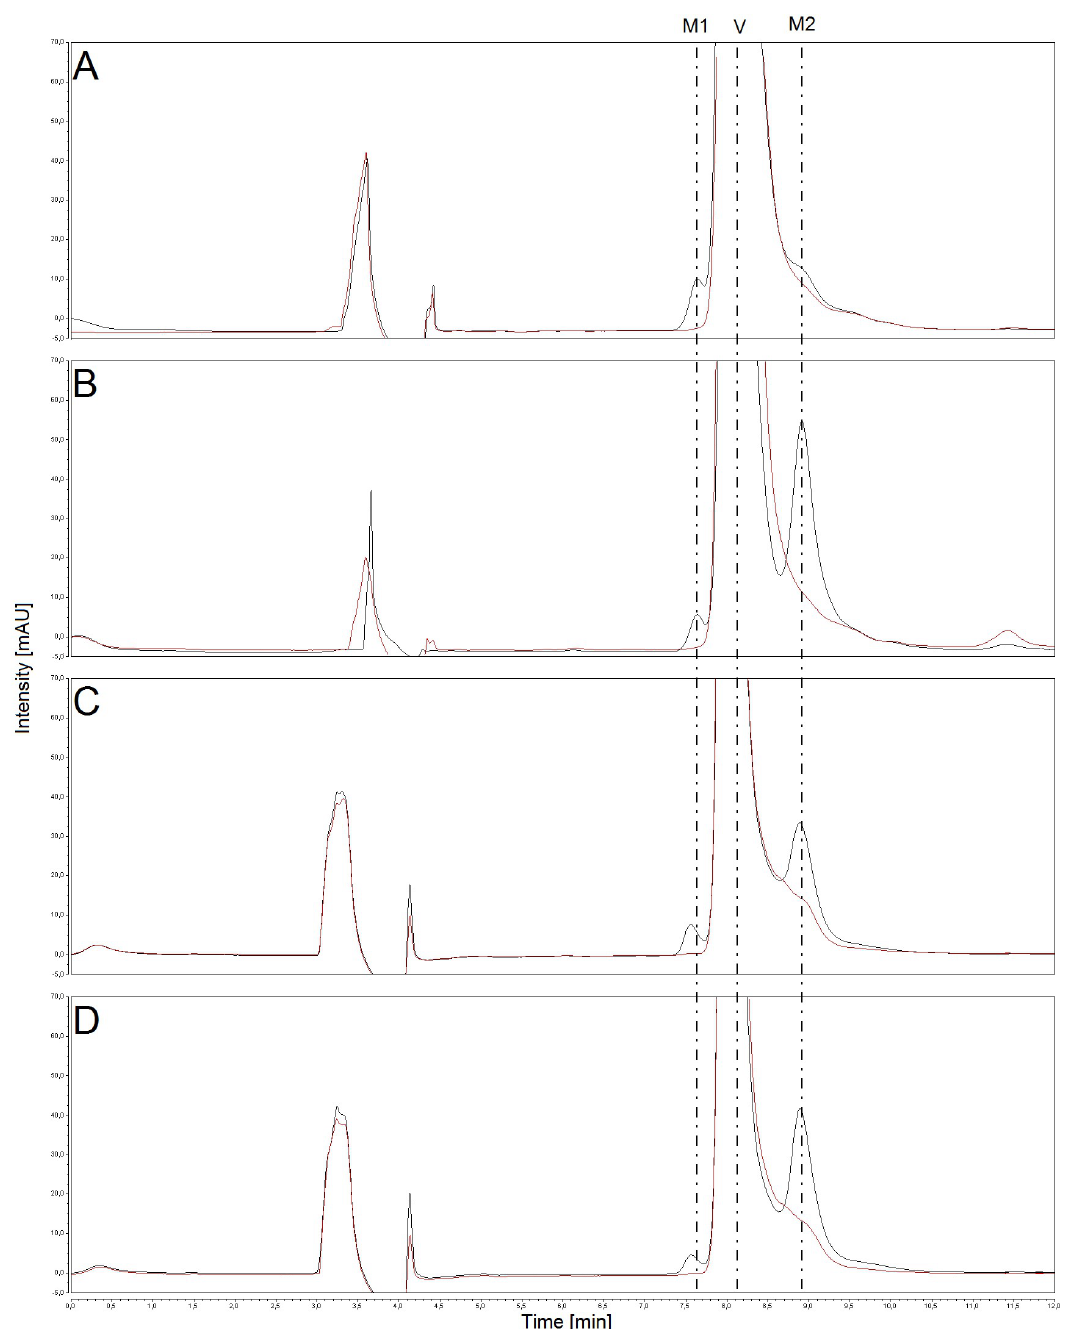
Figure 2. Separation of vandetanib and its metabolites formed by human ( A ), rat ( B ), rabbit ( C ) and mouse ( D ) hepatic microsomes in the presence of NADPH (black line) and without NADPH (control) (red line) using HPLC analysis. M1— N -desmethylvandetanib; V—vandetanib; M2—vandetanib- N -oxide.